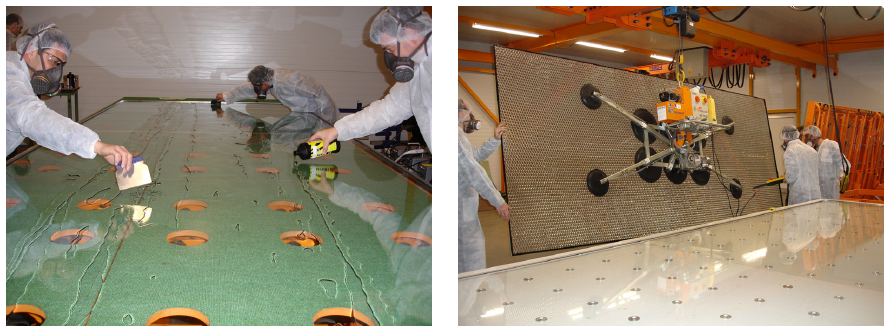
Figure 3a and b: A large glass-honeycomb panel during